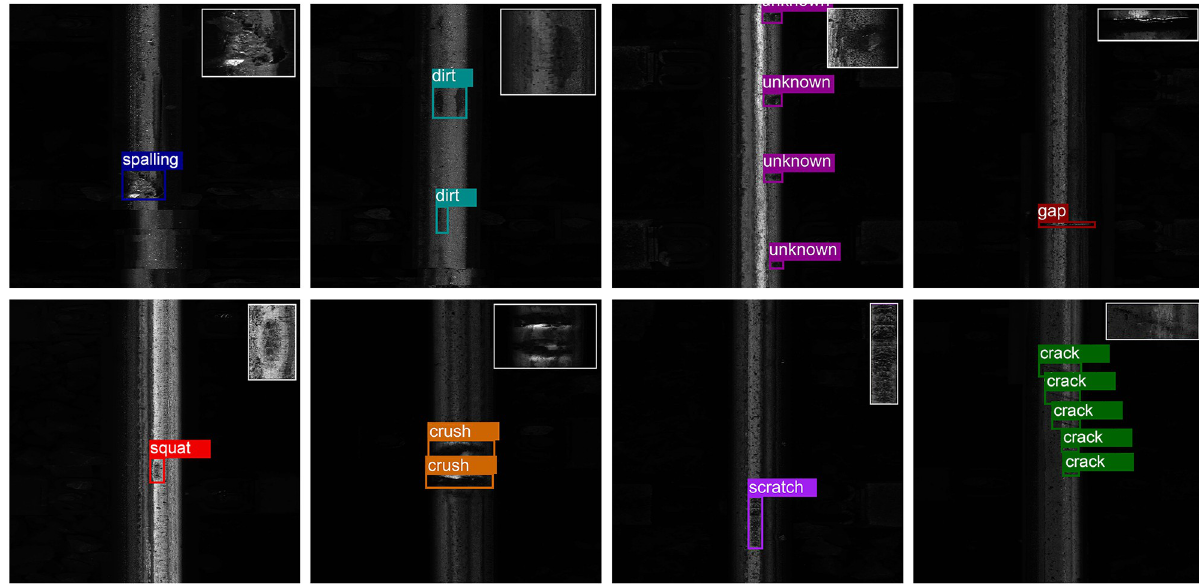
Fig 1. Samples of the rail defect dataset with 8 categories. From left to right, the first row contains saplling, dirt, unknown, and gap, and the second row contains squat, crush, scratch, and crack.